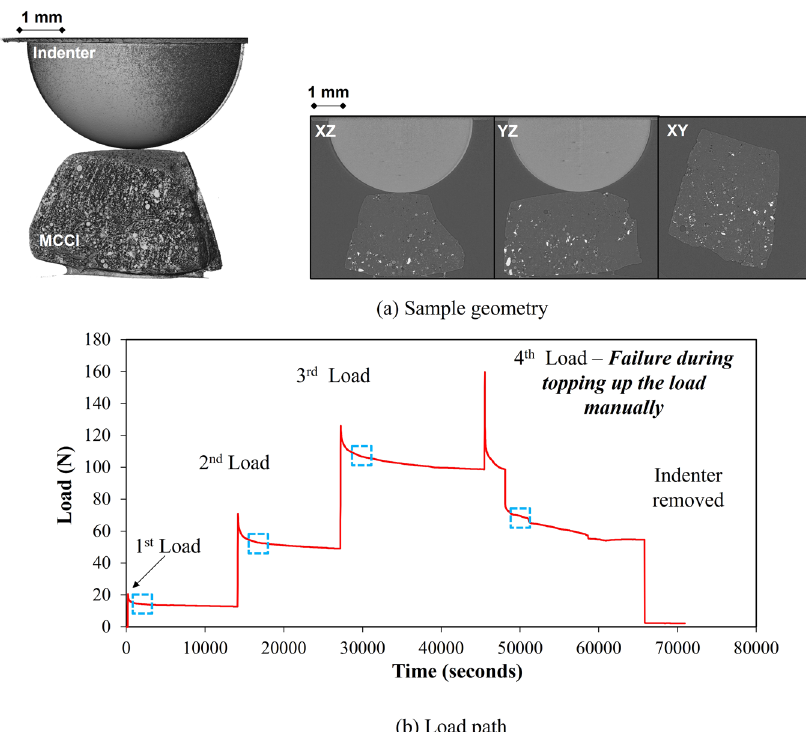
Fig. 1 Representative images. a A 3D overview of the MCCI sample (left side) accompanied by a selection of 2D orthogonal views (right side) and b the path adopted during